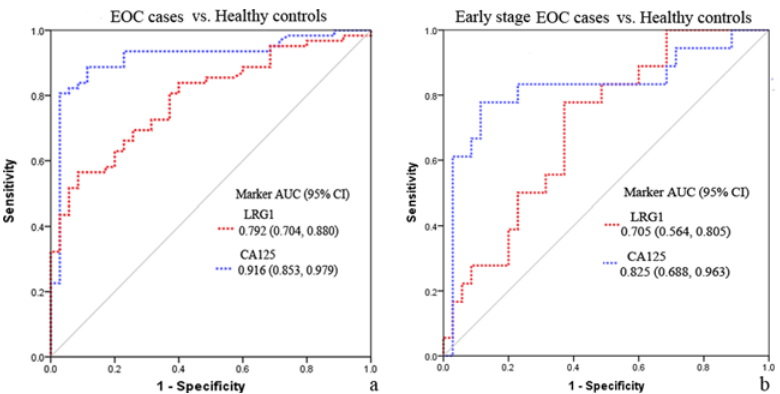
Fig 4. ROC curves comparing marker concentrations in cases to healthy controls for sample set 1. (a) ROC analyses for CA125 and LRG1 to differentiate EOC from healthy controls. (b) ROC analyses for CA125 and LRG1 to differentiate early stage EOC from healthy